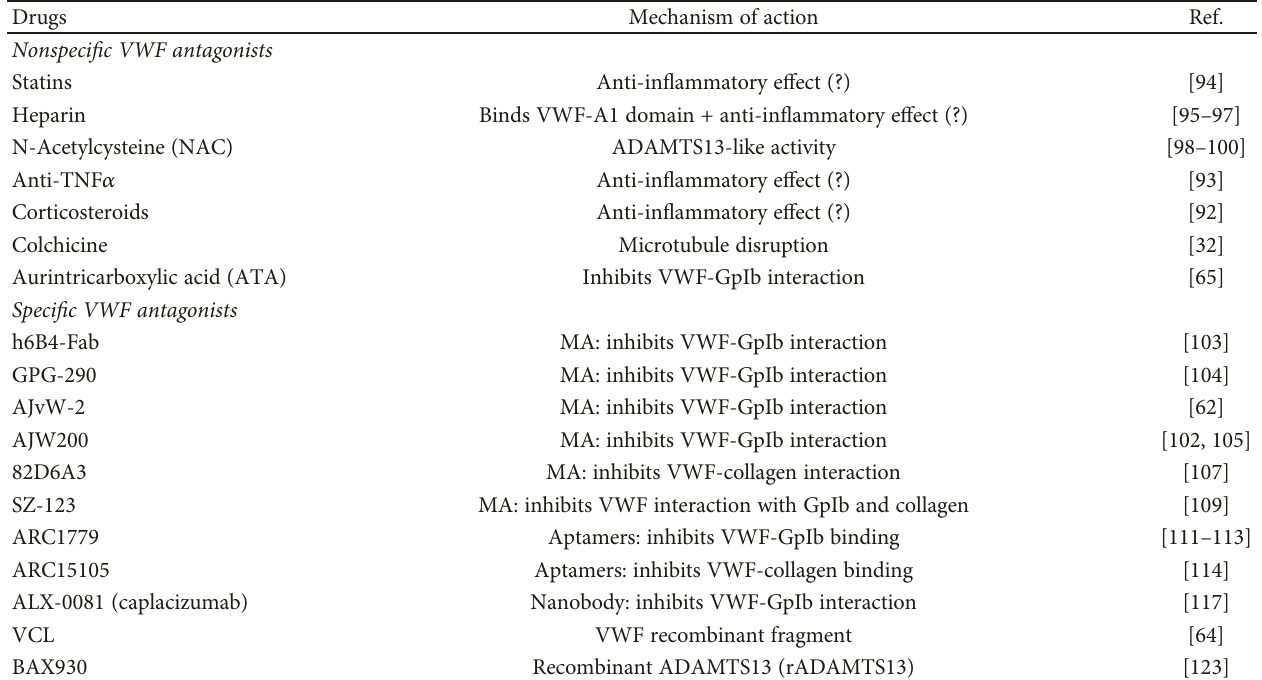
Table 1: VWF-targeted pharmacotherapy. Speci fi c and nonspeci fi c VWF antagonists and mechanism of action. VWF: von Willebrand factor; GpIb: glycoprotein Ib; Fab: fragment antigen binding; TNF: tumor necrosis factor; MA: monoclonal antibody; Ref.: references.